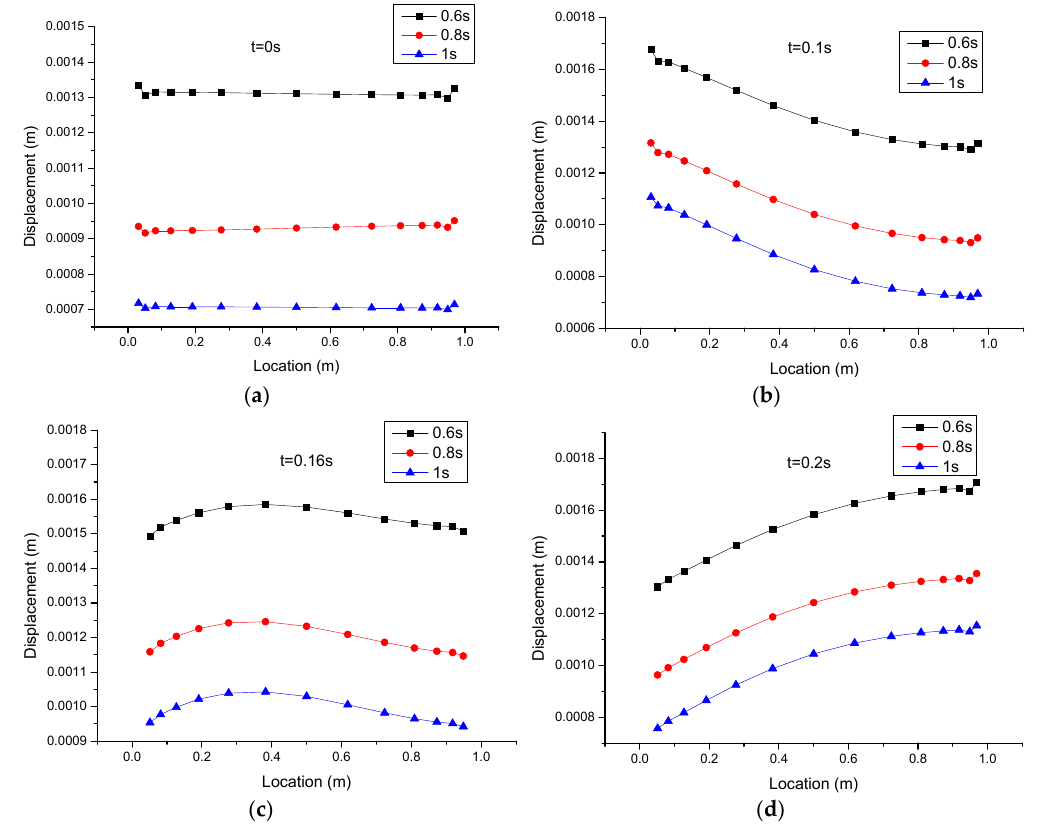
Figure 12. Comparison of tube wall deformation under different cardiac cycle lengths: ( a ) 0 s; ( b ) 0.1 s; ( c ) 0.16 s; ( d ) 0.2 s.